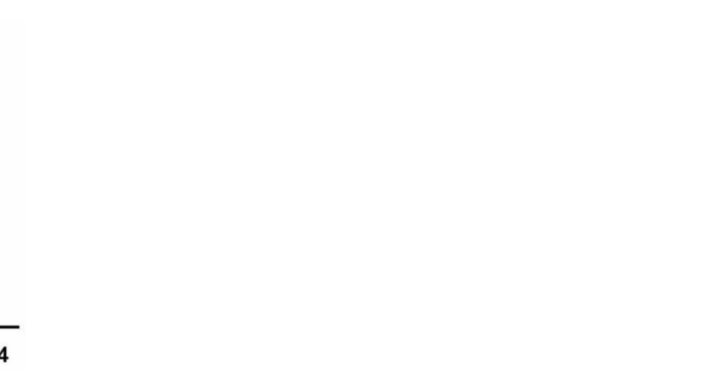
Figure 1. The expression level of the MET4 gene in the S. uvarum starting strain A9 and its transfor- mants. Enhanced expression or depression of the MET4 gene was assessed using the 2 − ∆∆ CT method to determine relative gene expression from RT-qPCR data with ACT1 as a housekeeping gene. Values were means ± standard error (SE) of 2 − ∆∆ CT ( n = 3). ** p < 0.01.